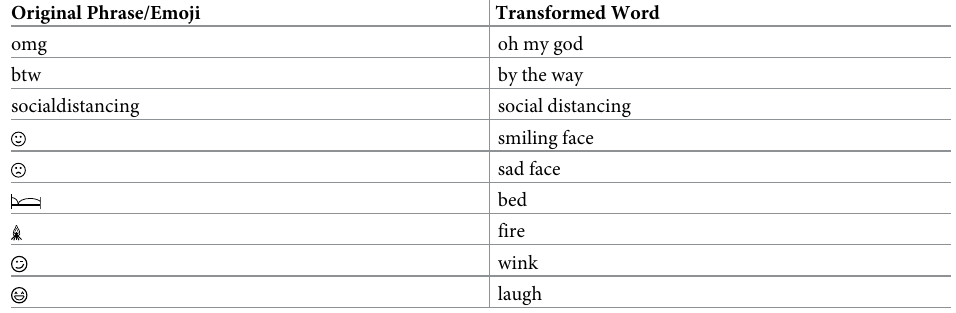
Table 1. Examples of word transformation that features changing symbols and emoji’s to words that can have semantic